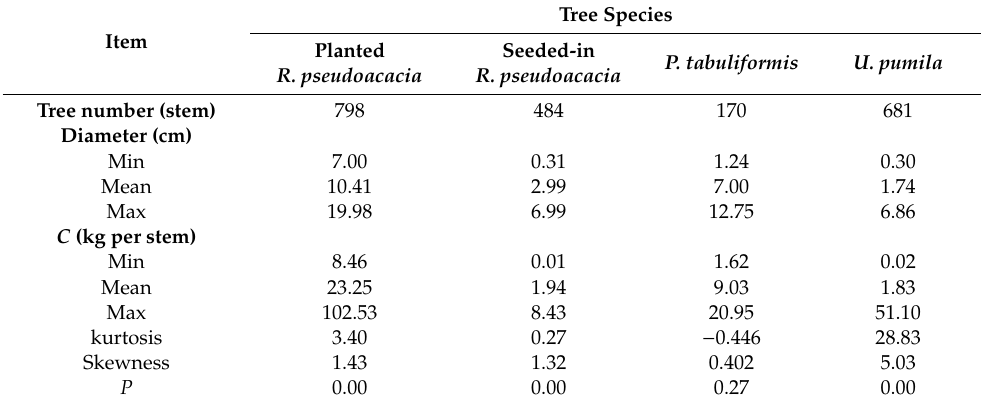
Table 2. Basic information of tree number, diameter and C for each tree species in Pingshuo opencast coal mine, China. Tree Species Item Planted Seeded-in P. R. pseudoacacia R. pseudoacacia